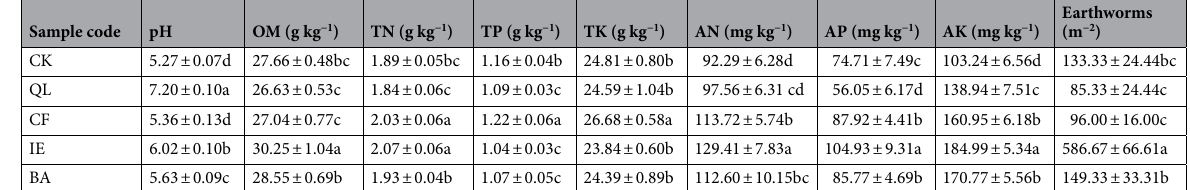
18.54%, and 15.69% higher than that of CK, respectively. In addition, the bulb yields negatively correlated with disease index and incidence (Fig. S1). Effects of different treatments on the availability nutrients of lily rhizosphere soils. The rhizo- sphere is the soil zone surrounding the plant roots where the features of the soil are influenced by the plants. Our study established that the five different treatments dramatically altered the physical and chemical properties of the rhizosphere during continuous cropping of lily (Table 1). The pH of rhizosphere soil with the QL treatments was 7.2, which was significantly ( p < 0.05) higher than the other treatments, followed by IE (6.02), with the low- est pH observed in CK (5.27). The soil OM (30.25 g kg −1 ), total nitrogen (TN, 2.07 g kg −1 ), alkali-hydrolyzable est in the IE treated of the continuous cropping lily rhizosphere. The OM, AN, AP and AK were significantly (p < 0.05) higher with IE than the other treatments. Total phosphorus (TP, 1.22 g kg −1 ) and total potassium (TK, 26.68 g kg −1 ) were the highest in CF and significantly ( p < 0.05) higher than other treatments. There were eight species of native earthworms in the five treatments, including one epigeic species ( Amynthas cortices ), four endogeic species ( Amynthas robustus , Drawida gisti , Drawida japonica , and Pheretima pingi ), and three anecic species ( Lumbricus terrestris , Metaphire guillelmi , and Pheretima guillelmi ) 26,27 . The local earthworms population were lower in QL (85.33 m −2 ) and CF (96 m −2 ; Table 1), because the presence of QL and CF would drives earth- worms away. IE treatment had the largest earthworm population (586.67 m −2 ) includes 421.33 m −2 exotic Eisenia fetida (epigeic species, compost earthworm) and 165.33 m −2 native earthworms (Fig. 3), which was significantly ( p < 0.05) higher than the other treatments and 3.4-times higher than CK (133.33 m −2 native earthworms only). High-throughput sequencing of microbial community from lily rhizosphere soil. The plant rhizosphere has been reported to harbor many unculturable microorganisms that benefit crop production. In this study, the Illumina MiSeq platform was used to sequence the V3-V4 hypervariable regions of the bacterial 16S rRNA gene. A total of 788,539 reads (52,569 ± 6280 per sample) with an average length of 469.74 ± 2.33 bp were obtained from the 15 rhizosphere samples of continuous cropping lily under the five different treatments. Using a cut-off of 97% sequence similarity, 2521 operational taxonomic units (OTUs) were obtained. After flat